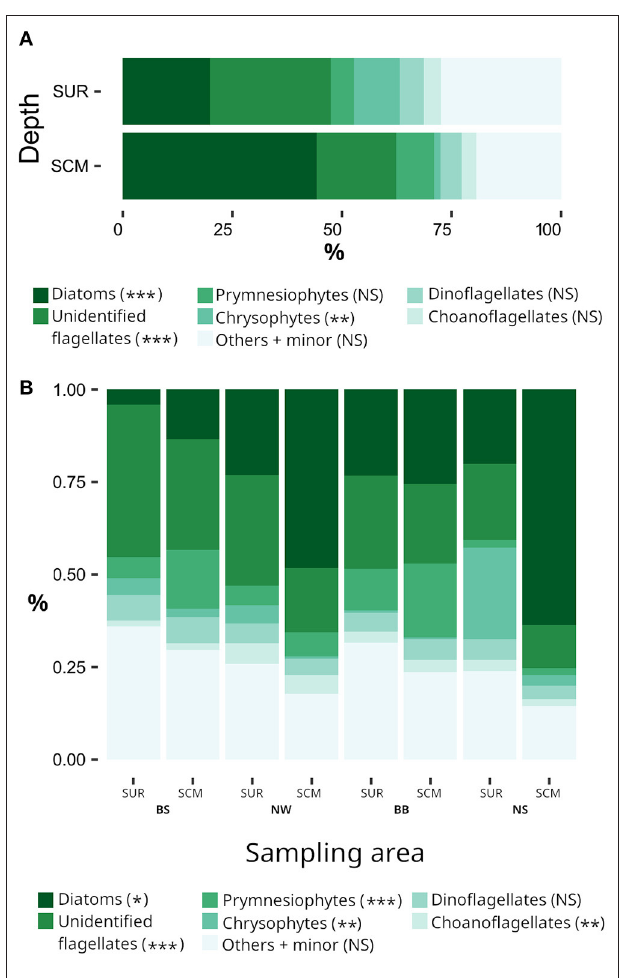
FIGURE 2 | Contributions of the main phytoplankton groups to total cell abundance (A) at the surface (SUR) and at the subsurface chlorophyll maximum (SCM) depth and (B) in the different oceanographic regions of the Canadian Arctic. No taxonomic data are available for the Labrador Sea. The PERMANOVA results are defined by *** p perm < 0.001; ** p perm < 0.01; * p perm ≤ 0.05; NS, not significant. The “Others + minor” group is composed of unidentified cells and cysts and prasinophytes, cryptophytes, dictyochophytes, heterotrophic taxa, raphidophytes, euglenophytes, and chlorophytes. In (A) the PERMANOVA results compare the SUR and SCM depth while in (B) the PERMANOVA results compare